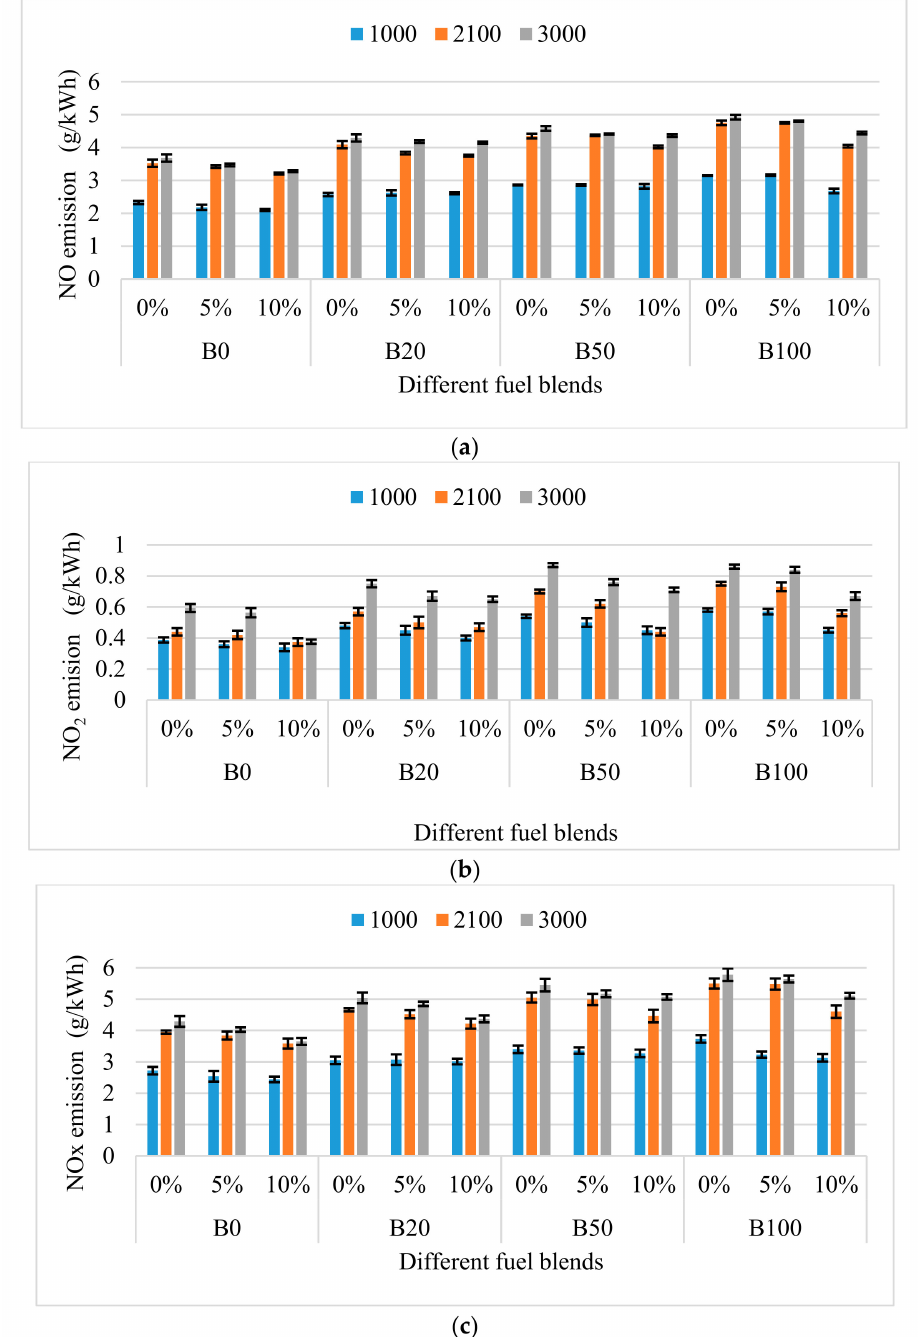
Figure 7. NO, NO 2 and NO x emission of different fuel blends at different engine speeds. ( a ) NO emission; ( b ) NO 2 emission; ( c ) NO x